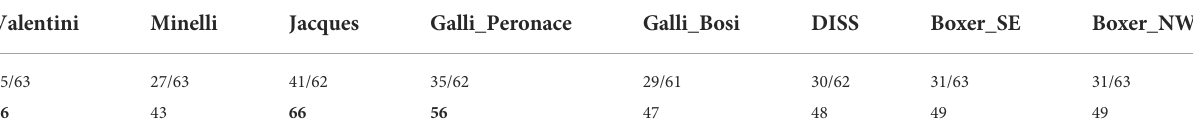
TABLE 3 Comparison between the deformation expected on the eight potential sources and the polarities of the 63 rank ‘ A ’ coseismic observations.